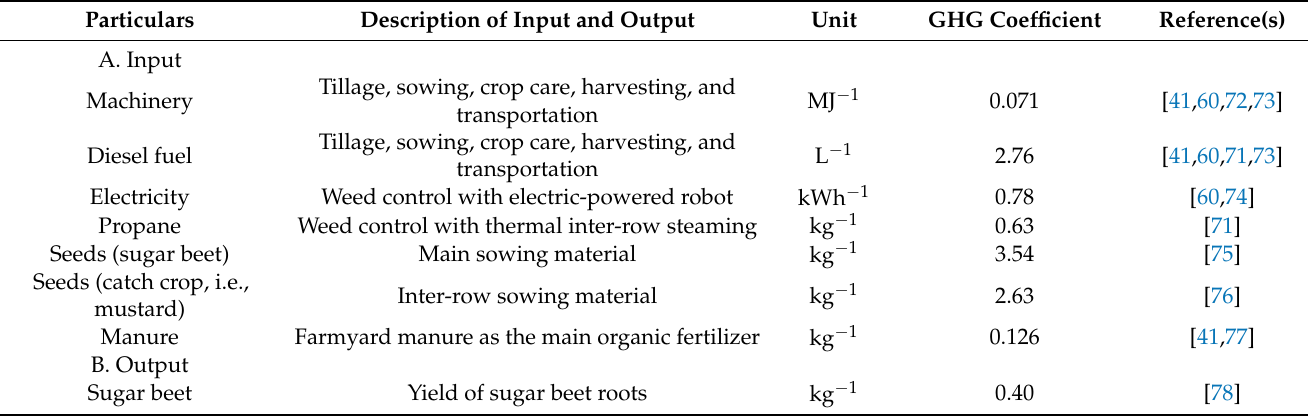
Table 2. GHG coefficients (kg CO 2 − eq unit − 1 ) of agricultural input and